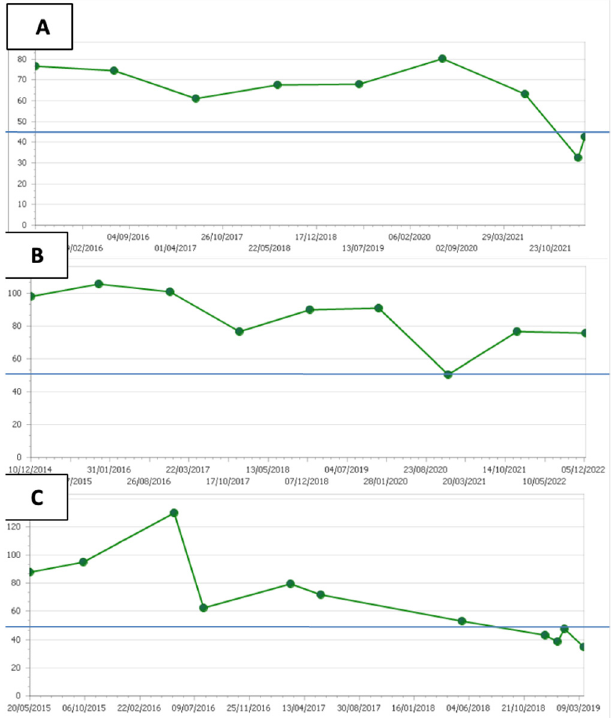
Figure 1. LDLc levels from 2015 to date. ( A ) Patient 2; ( B ) Patient 3; ( C ) Patient 4.